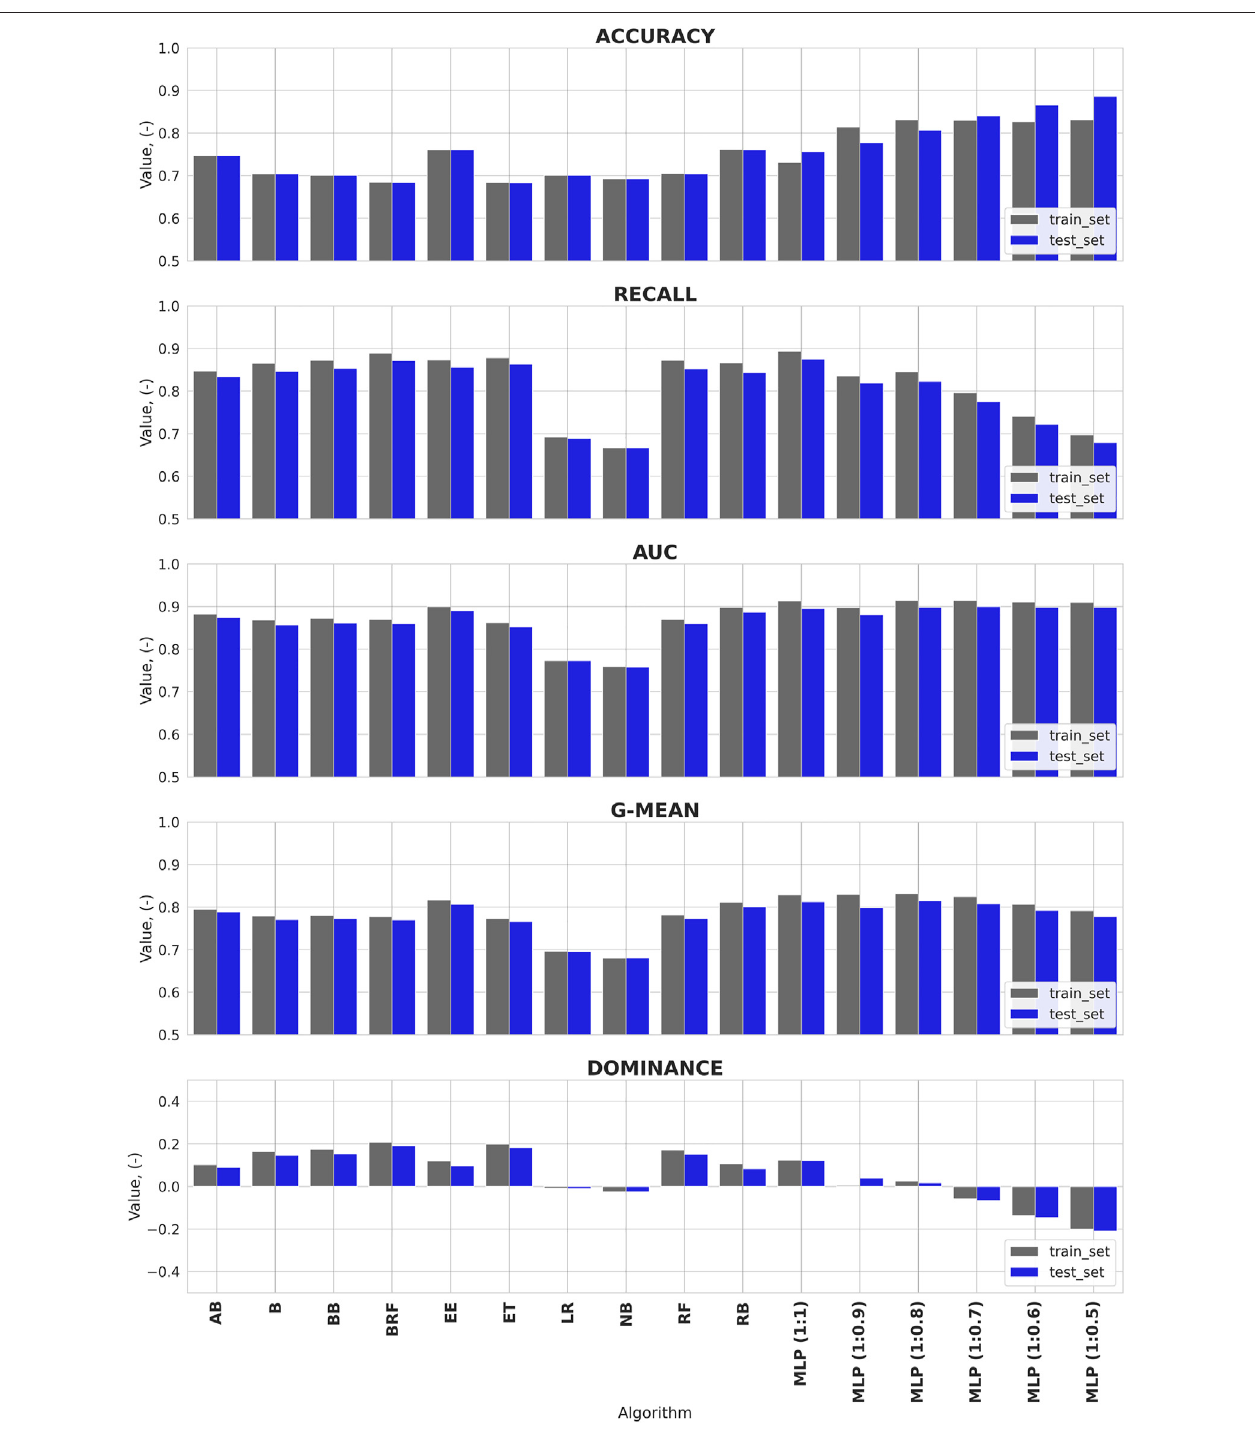
FIGURE 6 | Values of metrics for each